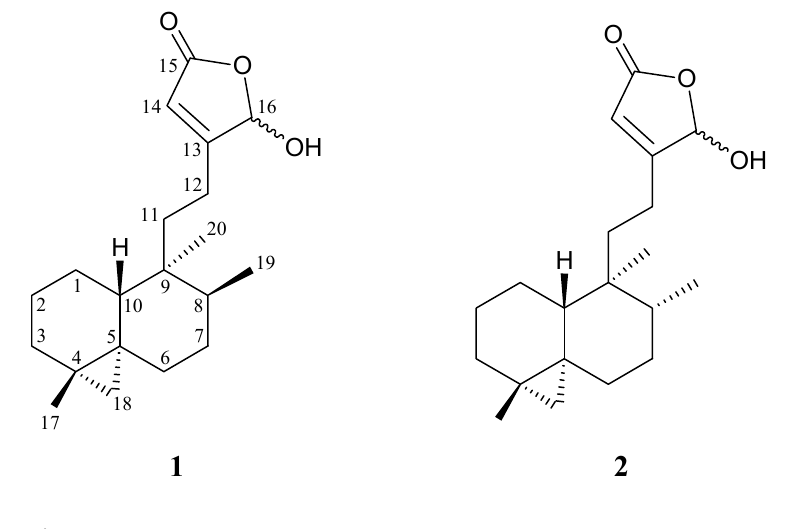
Figure 1. Structures of echinoclerodane A ( 1 ) and dytesinin A ( 2